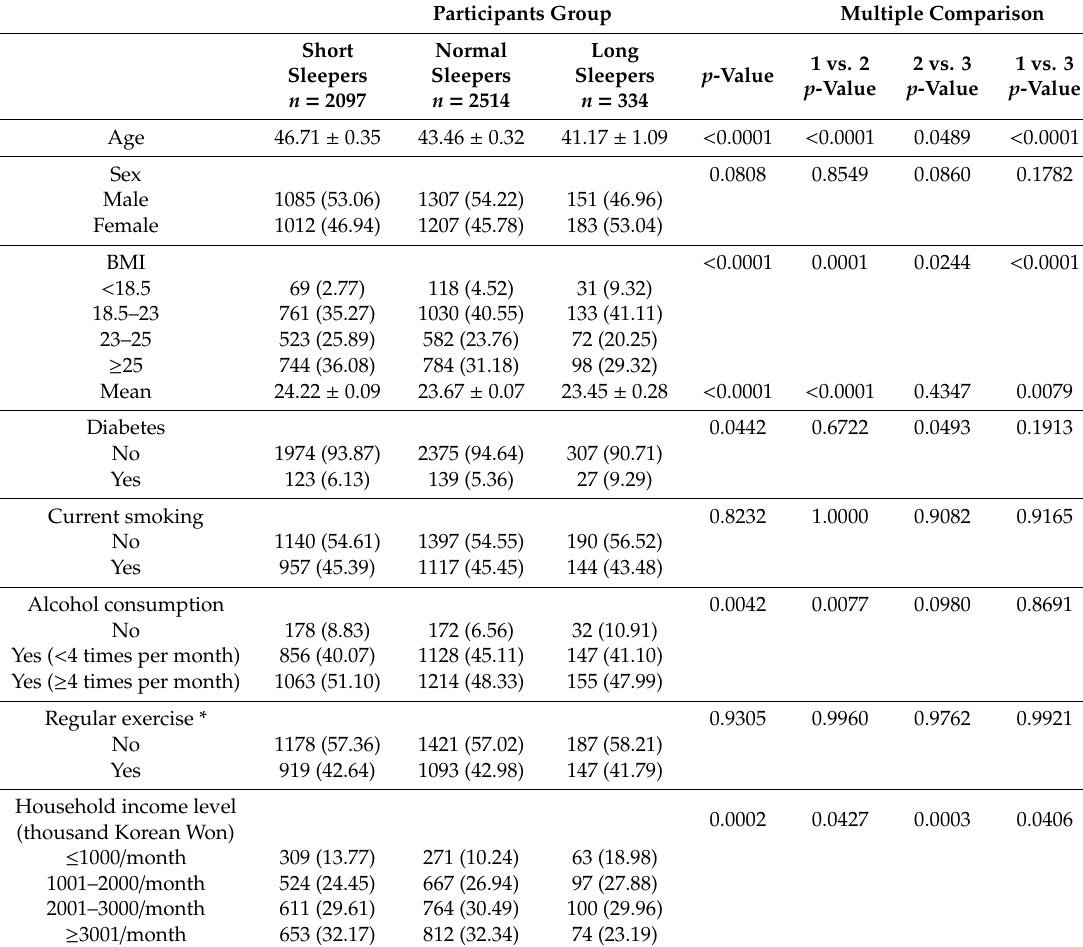
Table 1. Characteristics of the study participants according to sleep